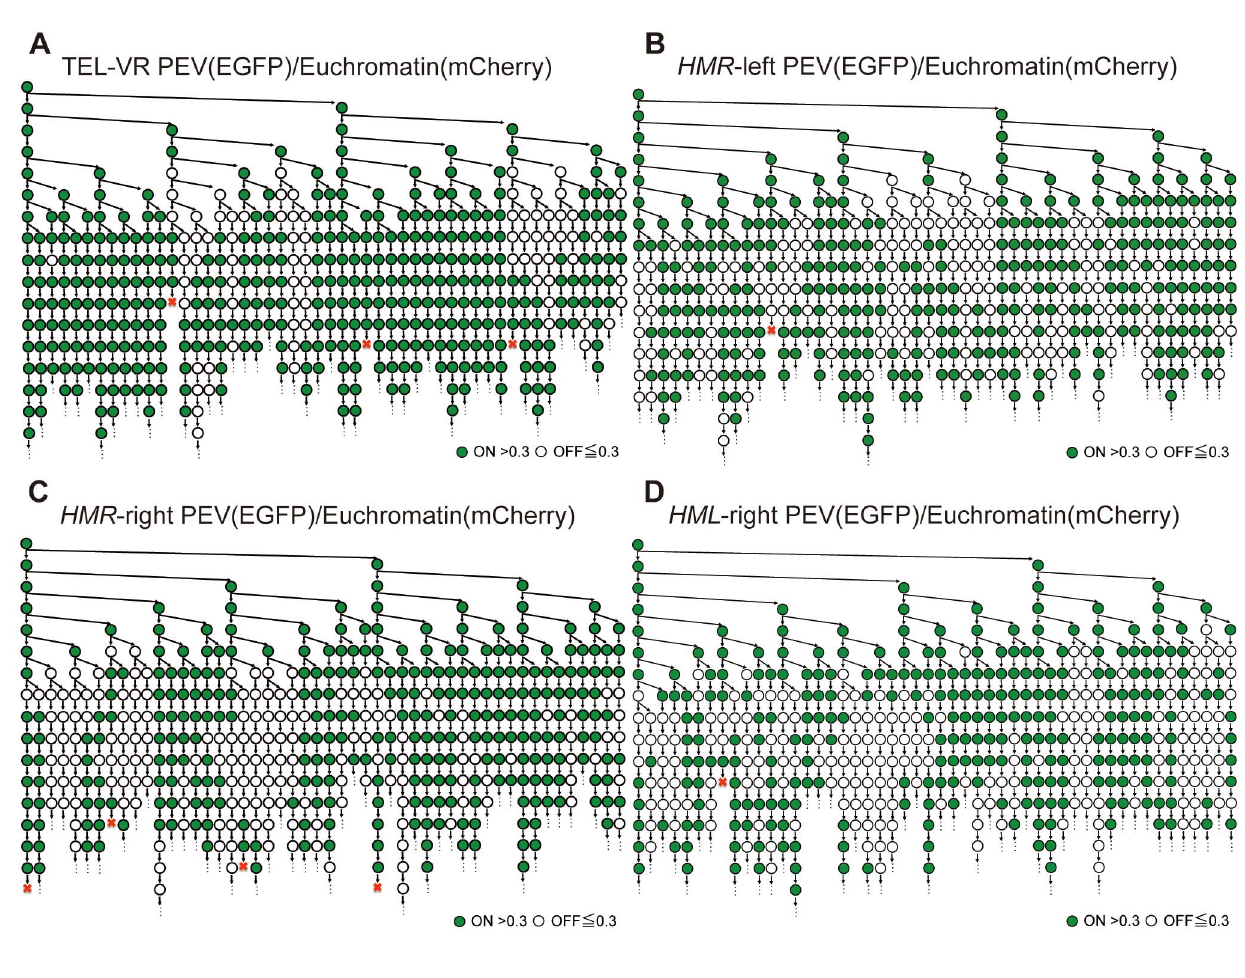
Figure 5. Representative expression lineage trees derived from a single cell. (A 2 D) The fluorescence intensities of single cells from the TEL- VR PEV/Euchromatin (FUY355) (A), HMR -left PEV/Euchromatin (FUY263) (B), HMR -right PEV/Euchromatin (FUY356) (C), and HML -right PEV/Euchromatin (FUY795) (D) strains were tracked in real time. The highest positioned circle on the left side of each panel indicates the first single cell; vertical arrows indicate the division and lineage of the mothers, whereas downward or horizontal arrows identify the daughter cells of specific mothers. Green cells indicate a fluorescence intensity . 0.3 and white cells indicate an intensity , 0.3. Dead cells are indicated by a red X. Not every cell is shown on this tree because of spatial constraints. Every cell was counted and the data are summarized in Table